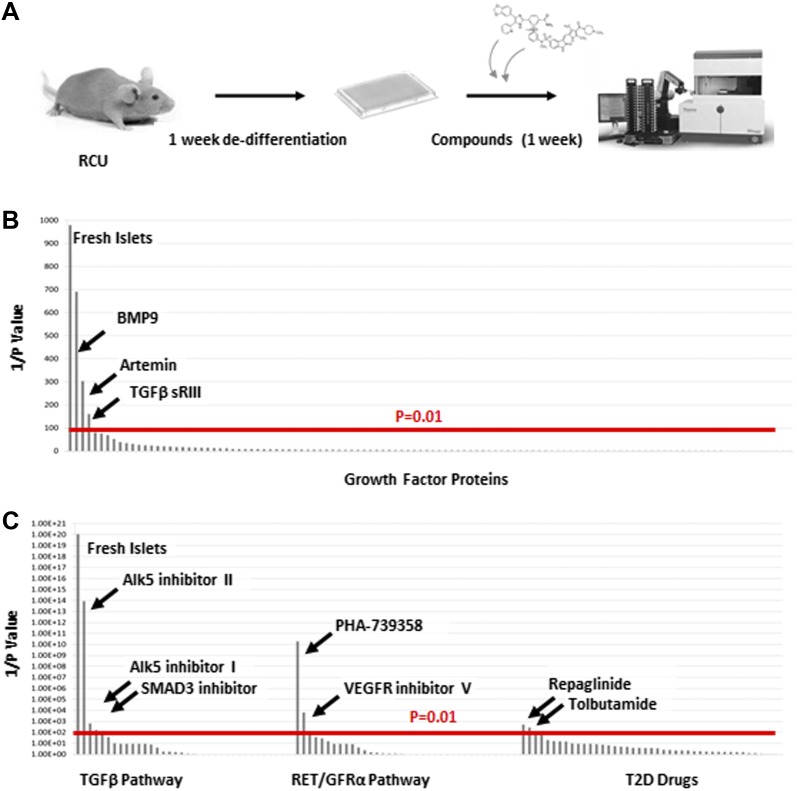
TGFβ pathway inhibitors and Artemin signaling reverse β cell de-differentiation.(A) Islets from adult RCU mice are isolated and plated on 804G matrix for 1 week in a 384-well plate format during which time the β cells de-differentiate. A compound library is added on day 7, and islets are cultured for an additional week in the presence of compounds. Each compound is tested in duplicates of two or three concentrations. Fresh un-manipulated RCU islets are used as a positive control, and DMSO- or untreated islets are used as negative controls. Islets are fixed on day 11 for automated imaging and subsequent analysis. Percentages of mCherry positive cells that co-express GFP are calculated for each well and used to identify conditions that significantly increase the number of GFP positive cells over negative (DMSO- or non-treated) controls. Positive hits are selected according to their statistical significance (p value) over the negative control. (B) Results of screen with 114 growth factor proteins. Factors are ordered from left to right based on the p-value of their Ucn3-GFP fluorescence over the negative (non-treated) control. For convenience, values on the Y axis are presented as 1/p-value. Red bar represents the threshold for statistical significance (p < 0.01). (C) Results of screen with 19 TGFβ pathway inhibitors, 18 RET/GFRα3 inhibitors, and 42 known T2D drugs. Factors are ordered from left to right based on the statistical p-value of their Ucn3-GFP fluorescence over the negative (DMSO-treated) control as above. For convenience, values on the Y axis are presented as 1/p-value. Red bar represents the threshold for statistical significance (p < 0.01). A full list of the factors tested is presented in the Supplementary file 1.